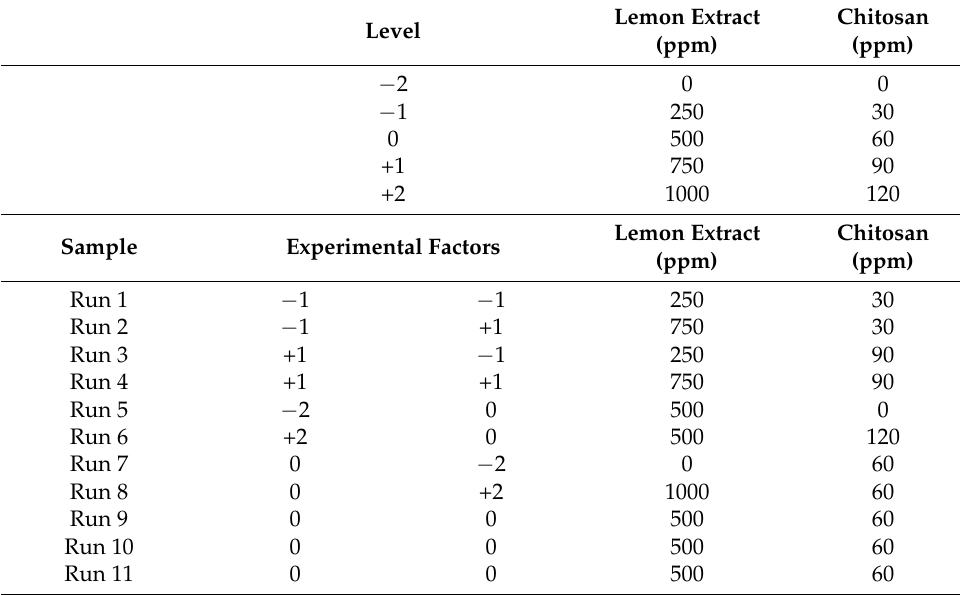
Table 1. Level, run, experimental factors and concentrations of the central composite